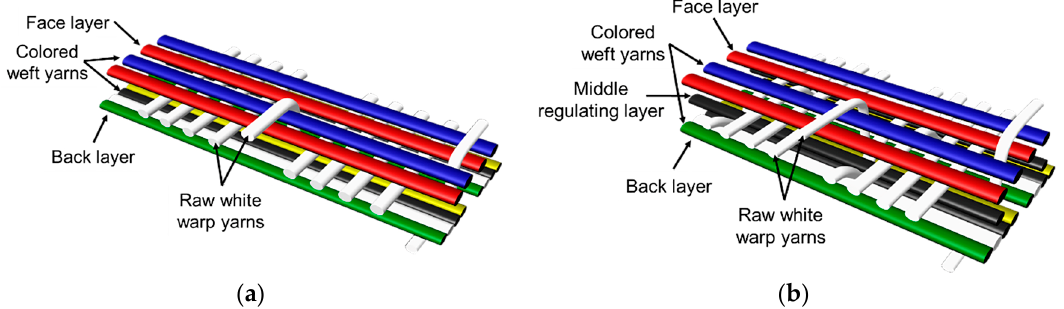
Figure 1. Weft-faced, weft-backed structures: ( a ) structure without regulating layer; ( b ) structure with regulating layer.